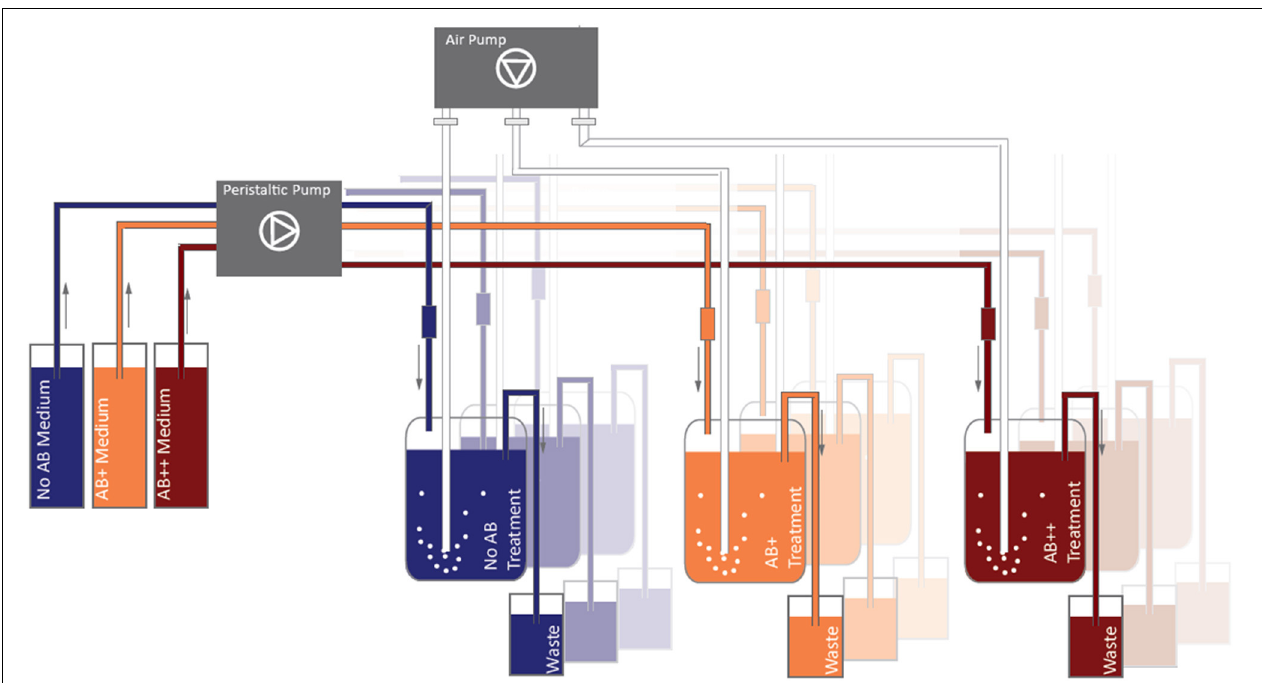
FIGURE 1 | Continuous culture design. Substrate was continuously renewed (0.2 d-1) through peristaltic pumps, aeration (fine bubbling) was performed in order to ensure a full mixing of the water in the vessel and to prevent the deposition of